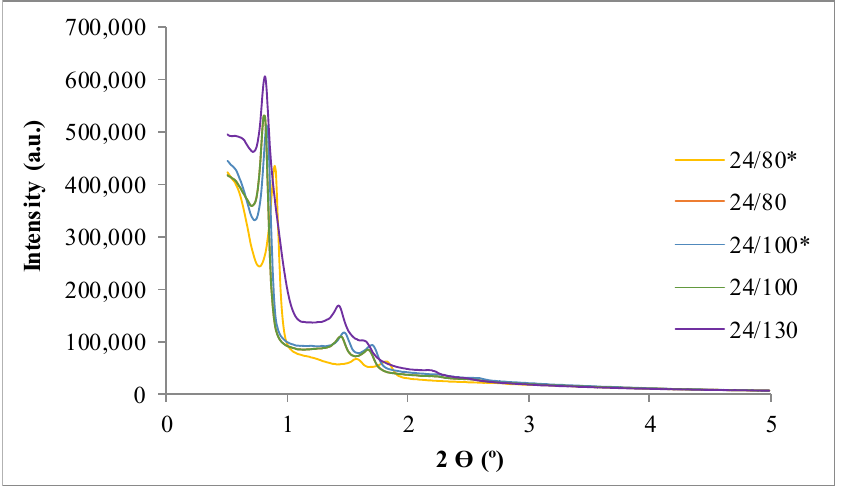
Figure 1. Low angle X-ray diffraction (XRD) patterns of samples for the study of the influence of temperatures (TH) and the effect of reduction of supernatant liquor. *Synthesis developed without reducing the supernatant liquor before the hydrothermal treatment.